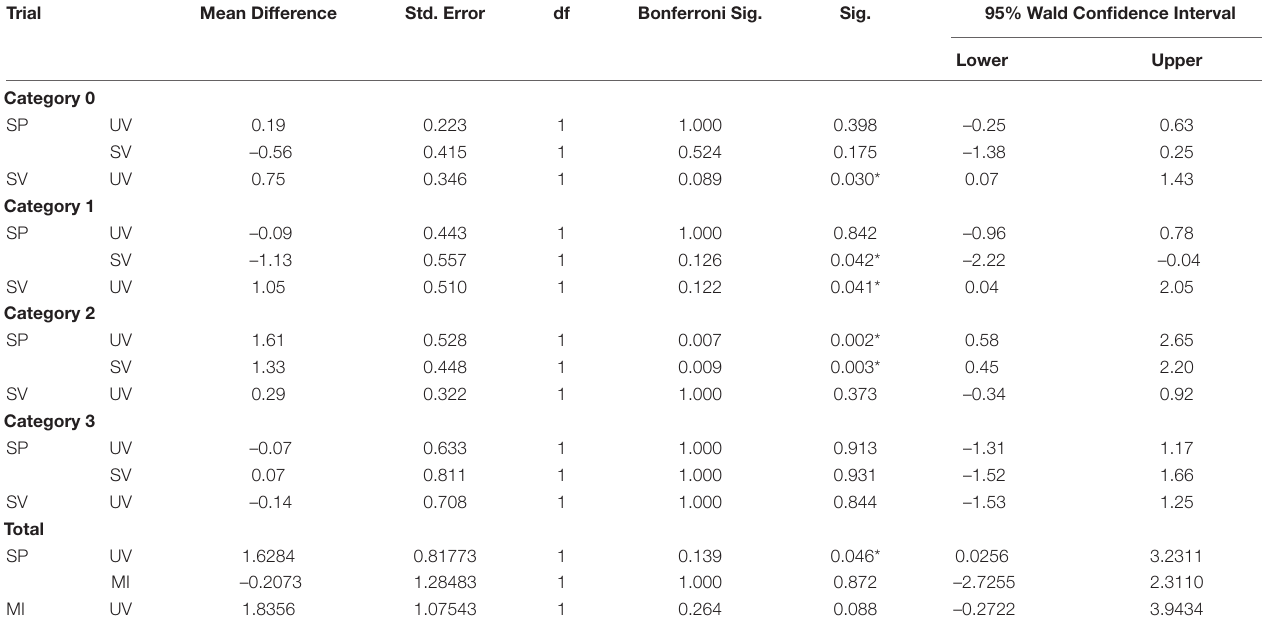
TABLE 6 | Between Group pairwise comparison of evaluator quality feedback and significance. Trial Mean